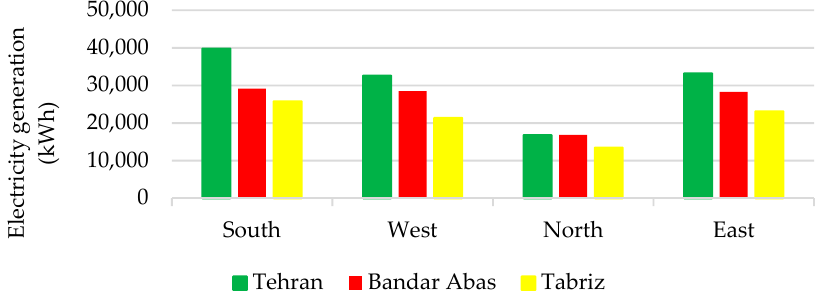
Figure 1. Electricity generation for Mono-Si for different sides.